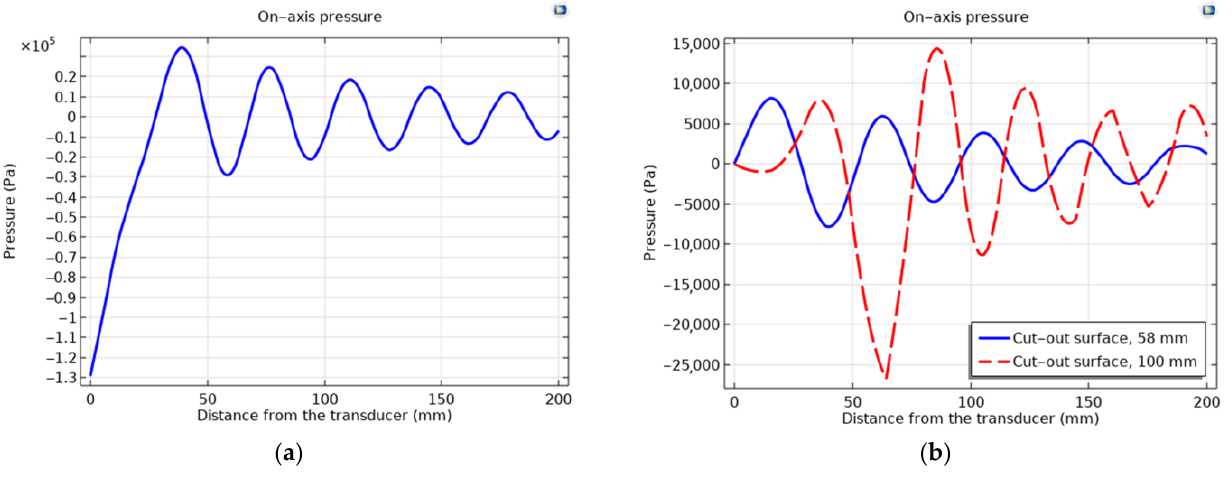
Figure 9. Distribution of the acoustic pressure level of an ultrasound wave propagating in a muscle medium, simulated by piezoelectric transducers, in the second natural mode: ( a ) with a flat surface at a resonant frequency of 48 kHz; ( b ) with a ring-shaped surface and the different diameters of: 58 mm at a resonant frequency of 38 kHz (solid line) and with a diameter of 100 mm at resonant frequency of 47 kHz (dashed line).